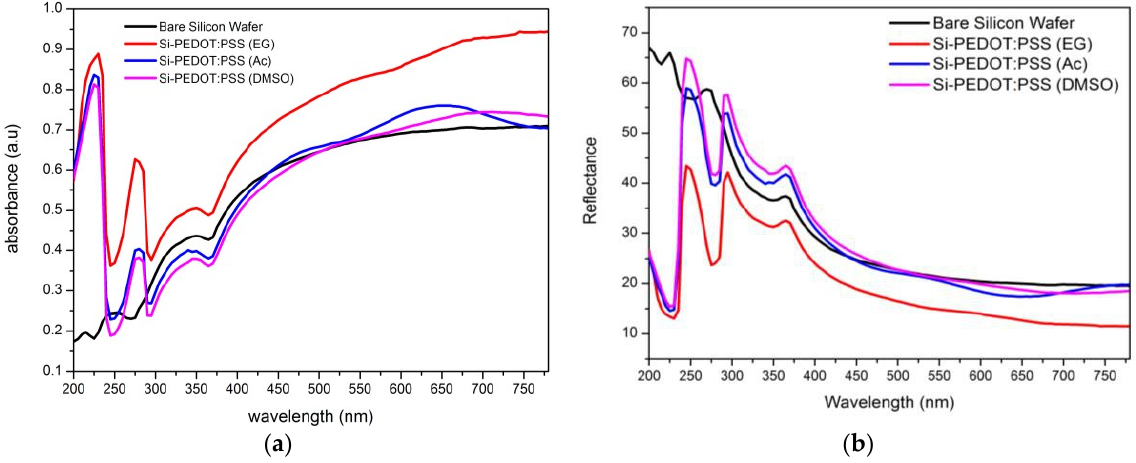
Figure 1. ( a ) Absorption and ( b ) reflectance spectra N-type Si wafer with PEDOT: PSS prepared in different solvents (EG) ethylene glycol, (AC) acetonitrile, and (DMSO) dimethyl sulphoxide with bare silicon as reference.